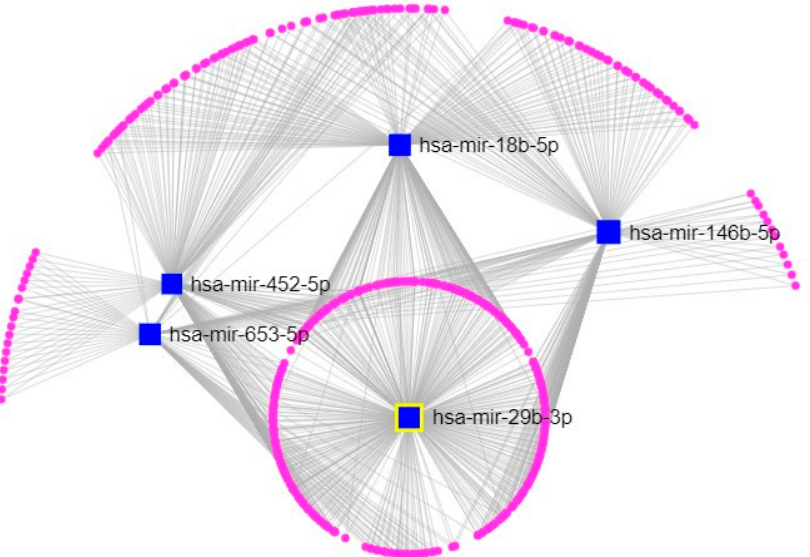
Figure 4. Network gene analysis of the differentially expressed miRNA. The network visualization of the differentially expressed miRNAs and their respective gene targets; blue squares represent miRNAs; purple circles represent genes targets. The visualization is based on significant deregulated miRNAs and their targets of the miRNet platform (https://www.mirnet.ca/) (accessed on 10 September 2022).